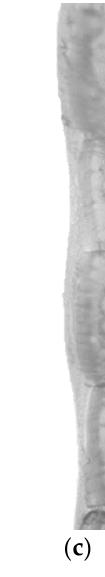
Figure 2. SEM image of the surface of a homogeneous Neosepta AMX membrane ( a ) and micrograph of its cross-sections in a dry ( b ) and swollen state ( c ) (b and c were adapted from [51]).